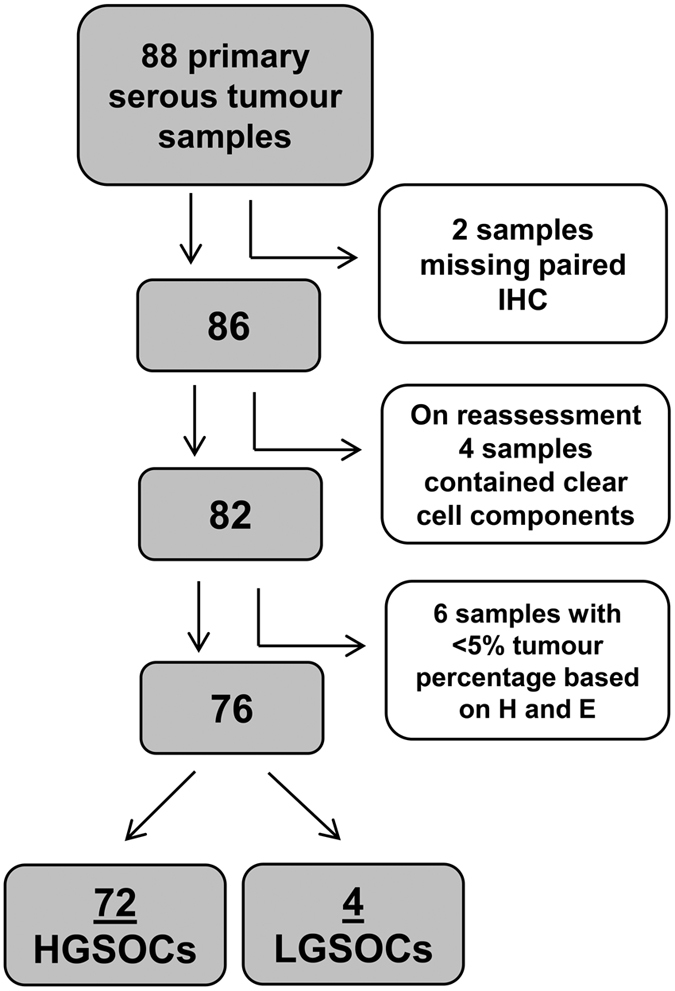
Flow diagram summarising inclusion and exclusion criteria from the primary tumour cohort.Eighty-eight primary ovarian tumours underwent MPS for TP53. Two samples were excluded as paired p53 IHC was unable to be obtained. Upon pathological reassessment, 4 samples were excluded due to the identification of clear cell components. A further 6 samples were excluded as they contained <5% tumour cells based on hematoxylin and eosin staining. Of the 76 remaining samples, 72 were HGSOC and 4 were LGSOC.